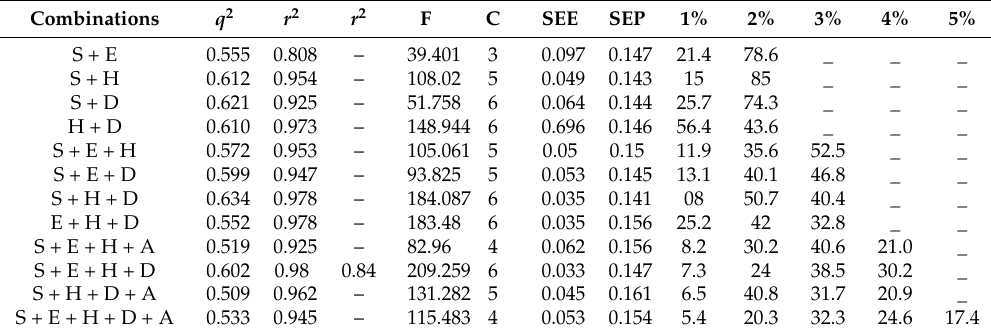
Table 2. Structure-based CoMSIA models along with field contribution in percentage.